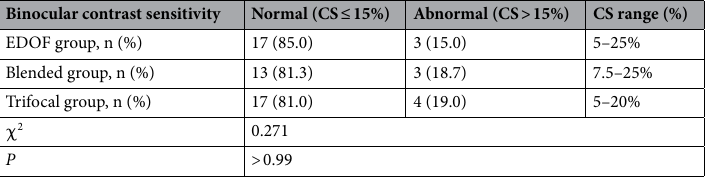
Binocular contrast